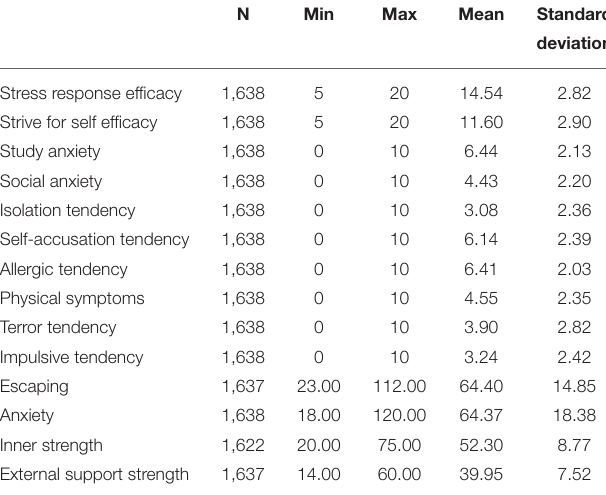
TABLE 1 | Variable